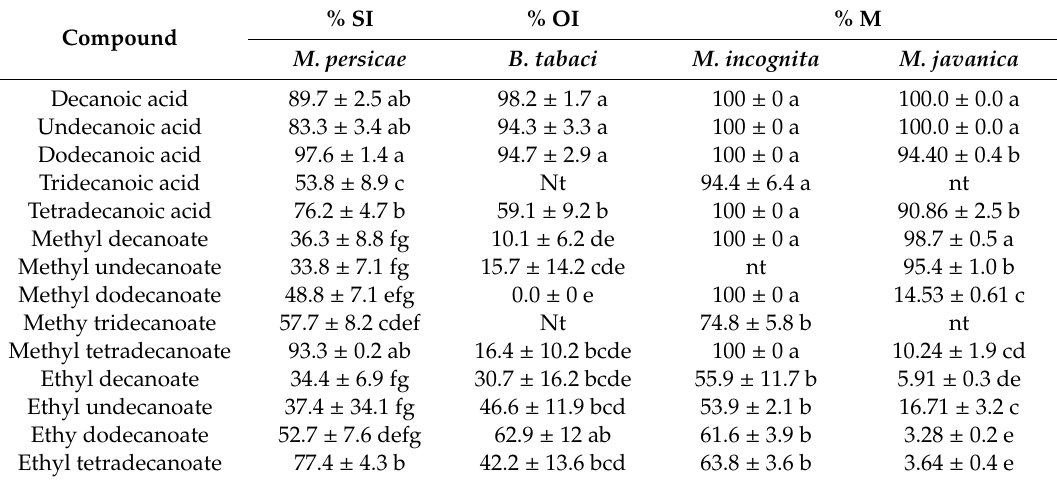
Table 3. E ff ect of fatty acids and ester derivatives on deterrence of two sap-sucking insects, Myzus persicae and Bemisia tabaci (50 µ g / cm 2 ), and mortality of two root-knot nematodes, Meloidogyne incognita and Meloidogyne javanica (0.5 µ g / µ